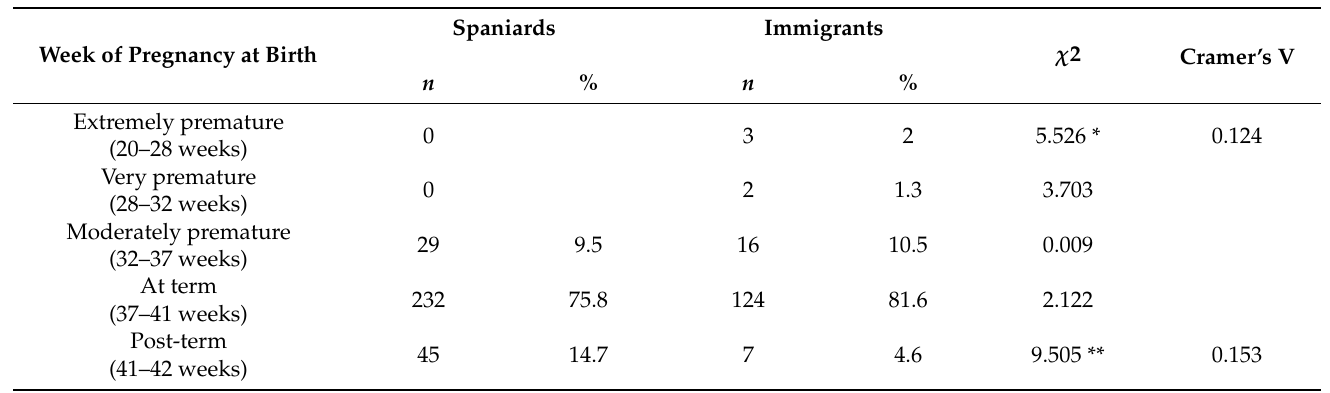
Table 7. Week of pregnancy at